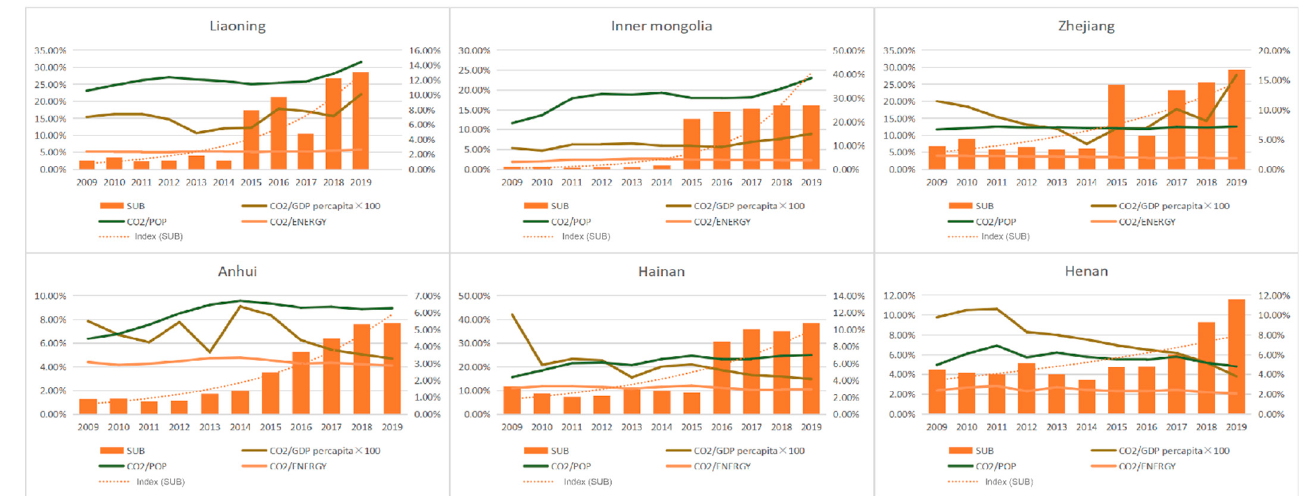
Figure 8. The Carbon Emissions and SUB change across 30 provinces in China (2009–2019).